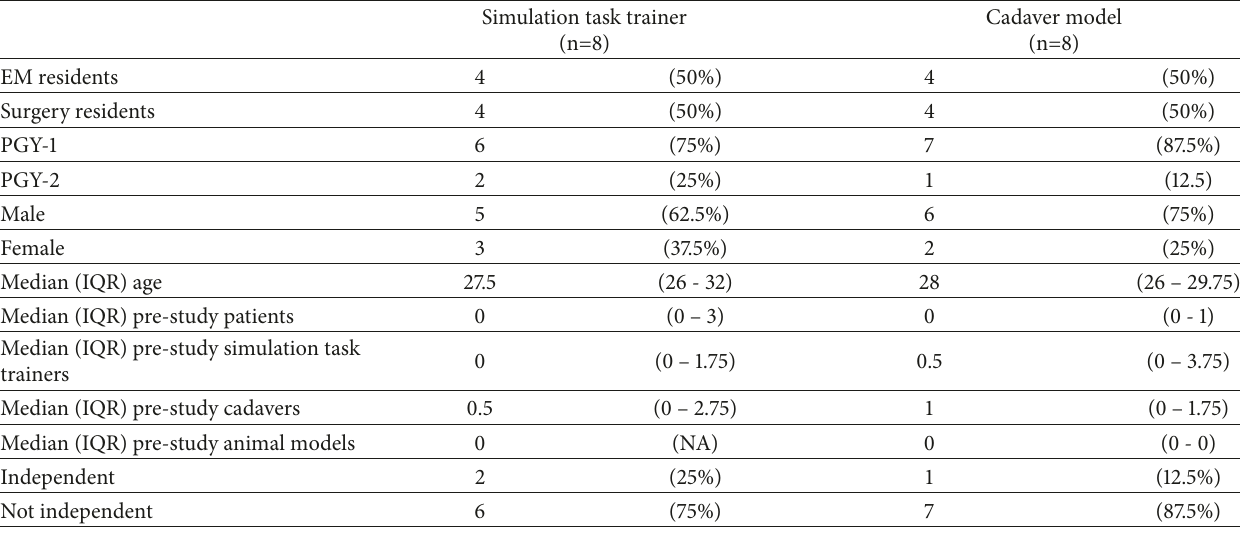
Table 2: Participant demographics and experiences.